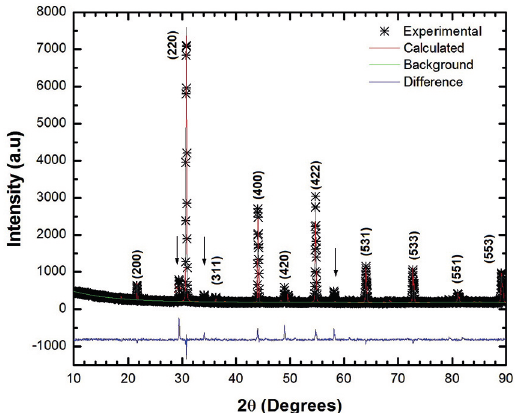
Figure 1: Characteristic XRD pattern for the complex perovskite Sr HoNbO . Symbols represent experimental diffraction data and 2 6 base line is the difference between experimental and simulated patterns (continuous line). The arrows indicate three peaks corresponding to non-double perovskite phase and belonging to a 0,8% of holmium